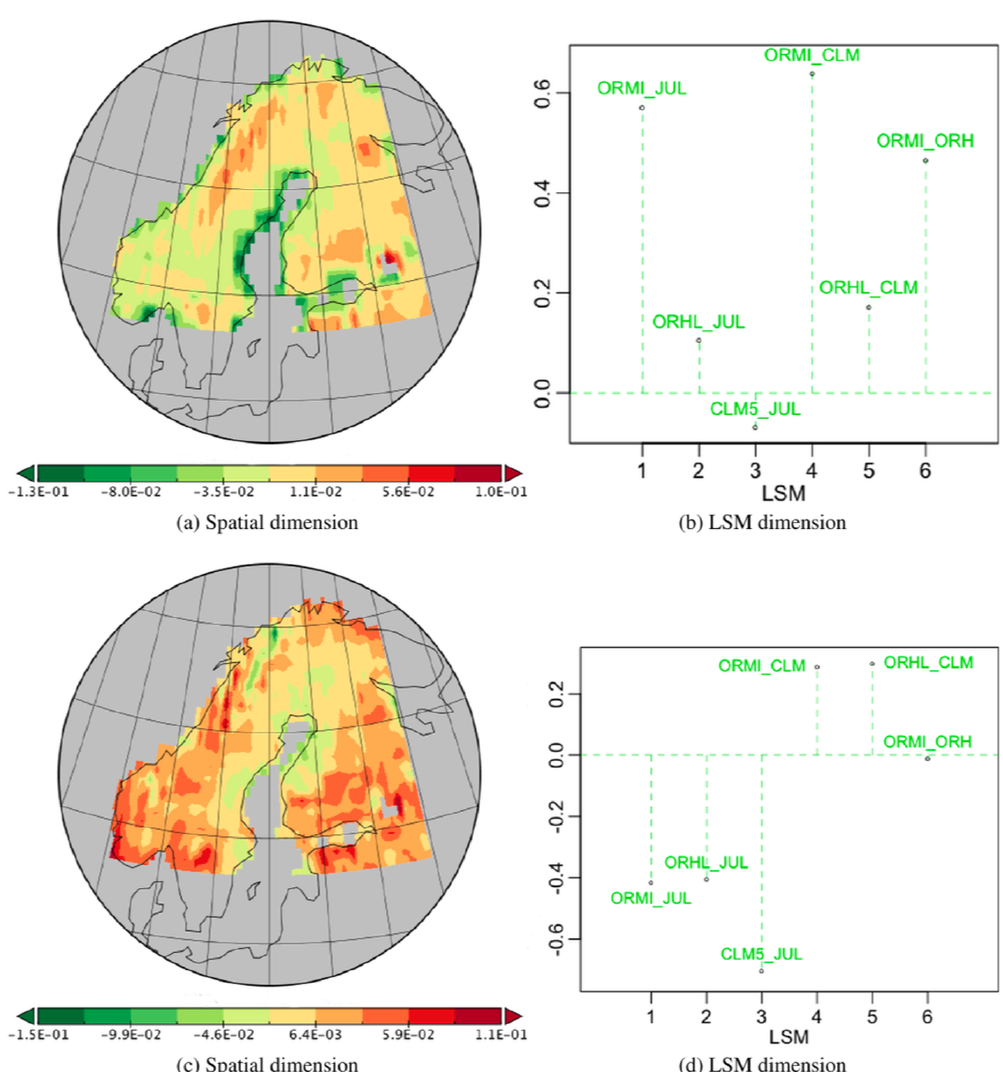
Figure 11. Spatial and LSM components of PTs -no-6 and 7 associated with the temporal component of vs111 in the PTA3 decomposition of the six normalized differences, representing 10.94% and 4.85% of the variability